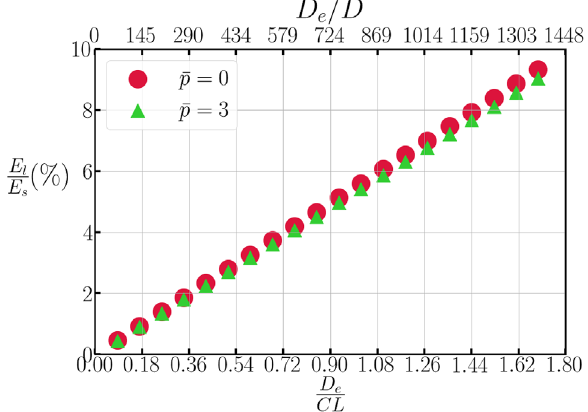
17. The ratio between loss and storage modulus as a function of dimension less elastic diffusion. D is η = ρ , where η is e the damping of the system and ρ is the density of the material. is the characteristic elastic wave speed, and L is the length of the system (not the lattice dimension). The top x axis shows the ratio between D and the diffusion coefficient D ¼ e 1 . 1 cm 2 = s in the electrophysiology model. The relation between E =E and damping of the system is linear in 0.1% strain and at l s zero damping; loss modulus is zero. The penalty volumetric =E pressure p slightly decreases the E ratio in high damping l s